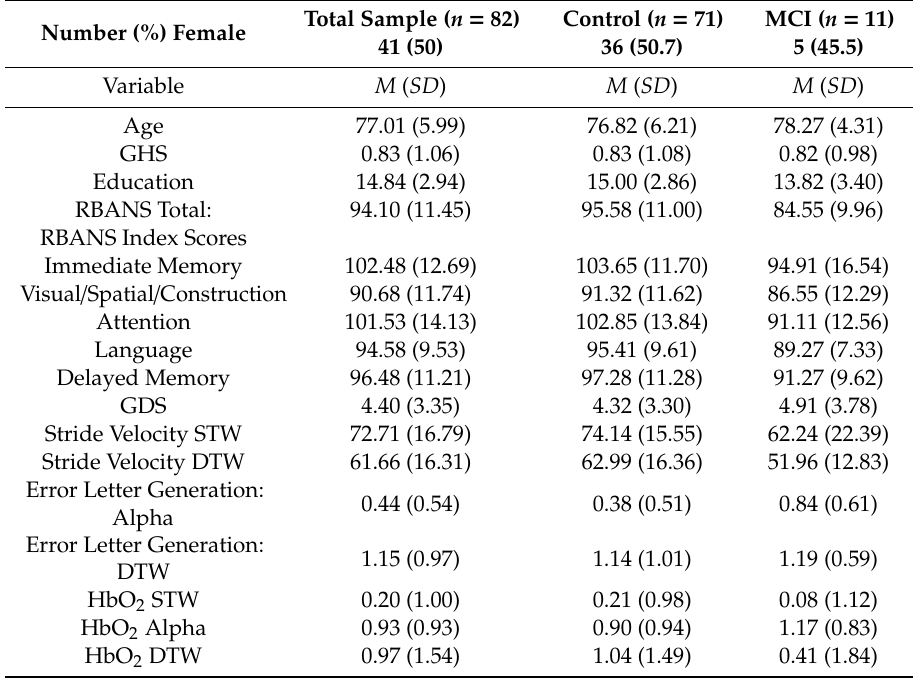
Table 1. Descriptive Statistics of the Study Sample.